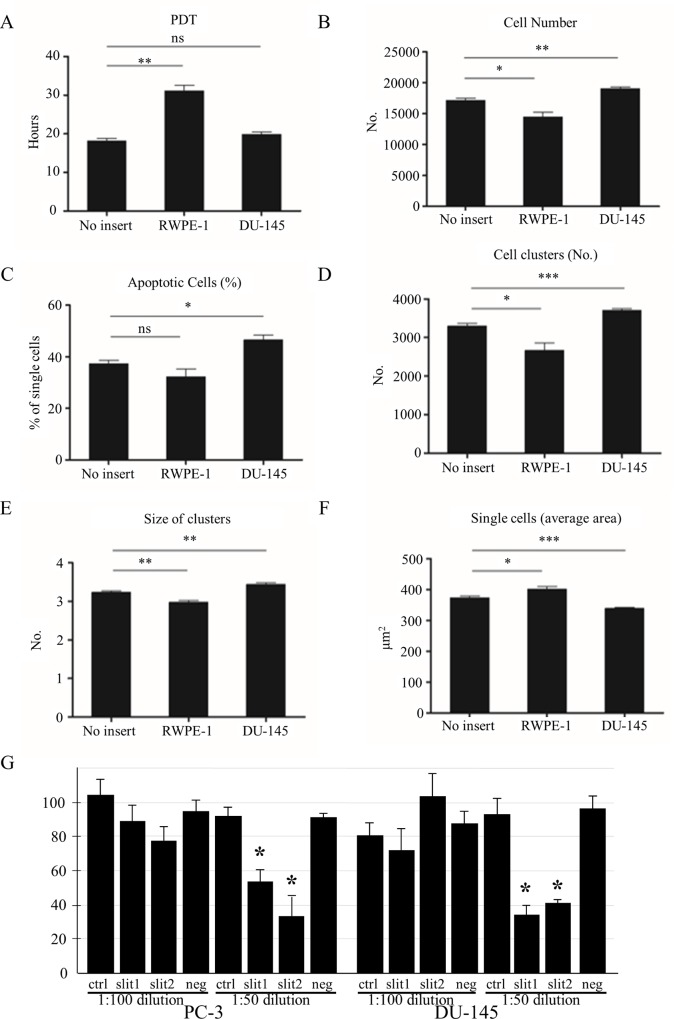
Phenotypic analyses of tumour cells in co-culture experiments.In each panel is shown the phenotypic characteristic of the tumour cells alone (DU145, no insert), the tumour cells in the presence of normal (RWPE1) or tumour cells (DU145). The presence of normal cells are seen to (A) increase the population doubling time (PDT), (B) decrease the total cell number, (C) have no significant effect on apoptosis, (D) decrease the number and (E) size of the cell clusters and (F) increase the number of single cells. Each of these changes shows a normalisation of the phenotypic characteristics of the tumour cells by the presence of the normal cells. In contrast co-culture with DU145 tumour cells is seen to have the opposite effect and to increase the tumour phenotype of the tumour cells. Panel G shows the results of a clonogenic assay performed on two different tumour cell lines (DU145 and PC-1). The figure shows that the addition of 1:50 dilution of culture media, conditioned by over-expressing Slit-2 induce at least 60% reduction in cell survival respect to control cultures.